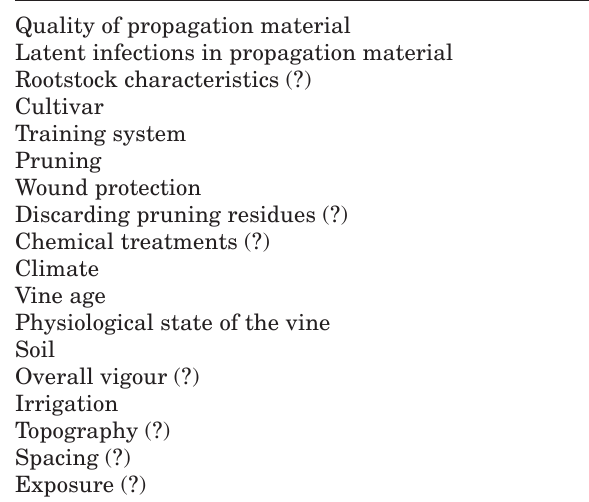
Table 1. A list of factors that may be significant in esca development. Factors accompanied by a question mark (?) have not yet been shown to be